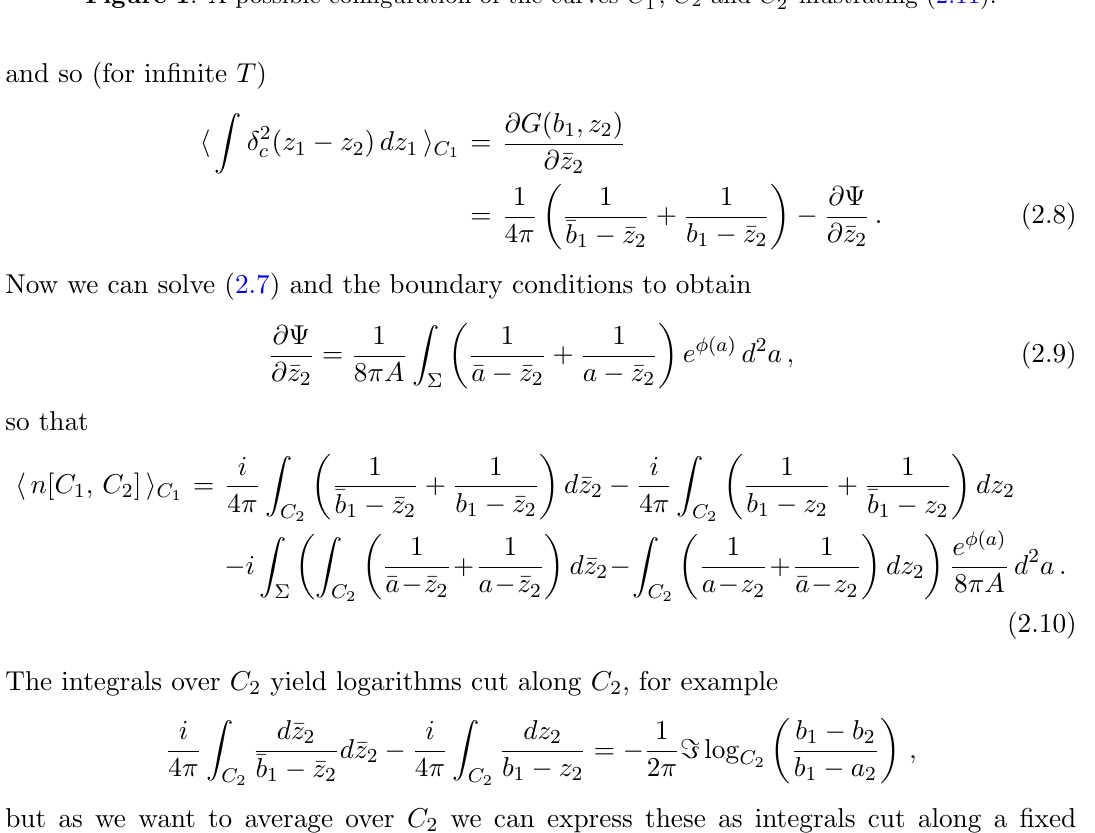
Figure 1 . A possible con(cid:12)guration of the curves C (cid:3)